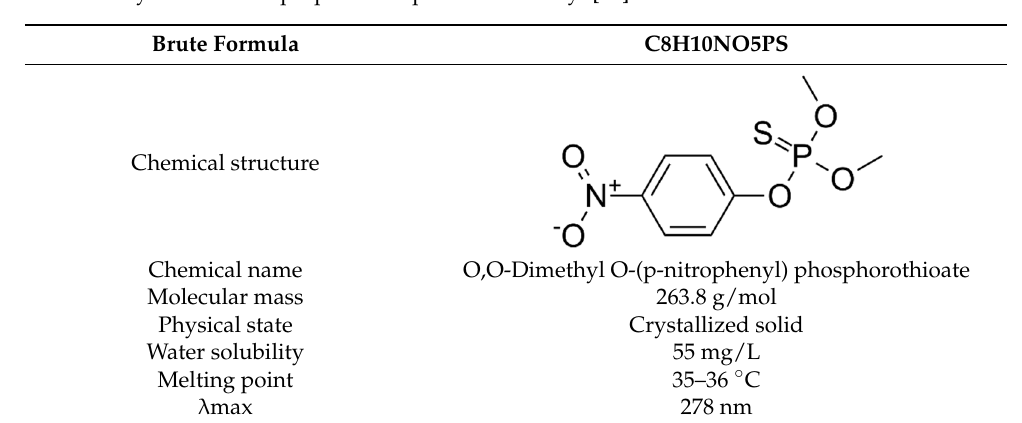
Figure 15. ( a ) Photocatalytic degradation of RhB using BiPO 4 in the presence of a series of scavengers. Irradiation time: 12 min, RhB = 5 mg L − 1 and (scavenger) = 4 mmol L − 1 . ( b ) Schematic diagram representing proposed degradation mechanism of BiP-500 ◦ C.